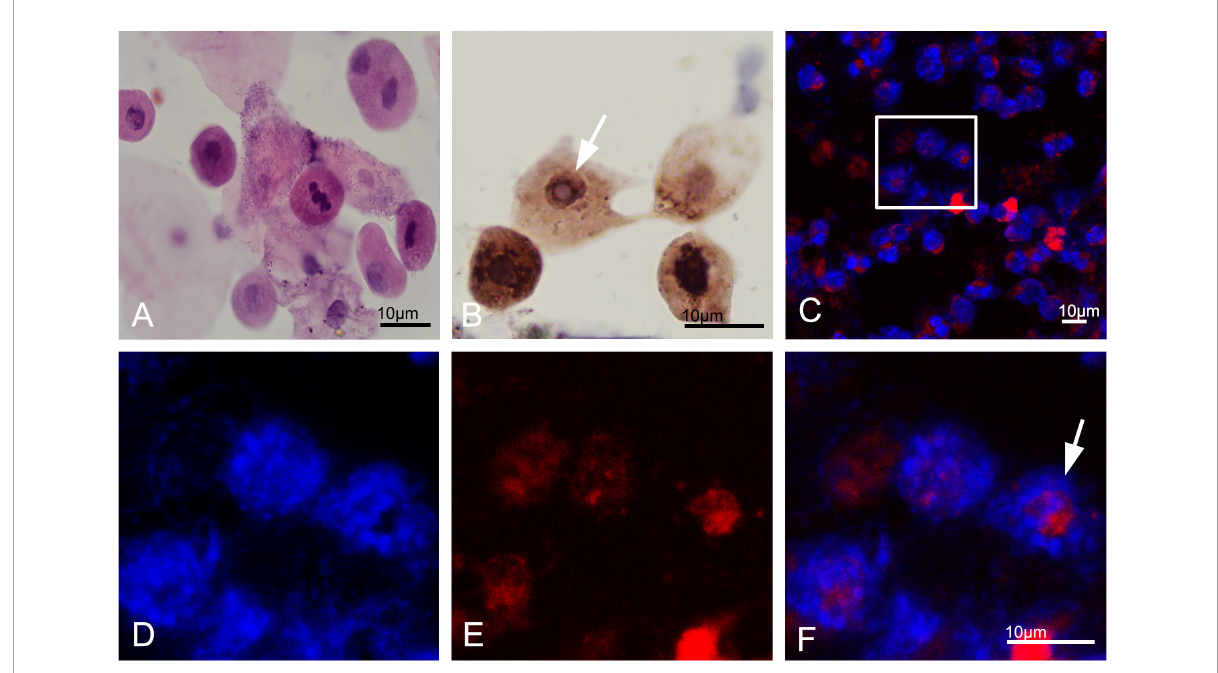
FIGURE4 Urine cytology in neuronal intranuclear inclusion disease (NIID) patients. Leukocytes, epithelial cells, and epithelial cells were observed in the urinary sediment on Giemsa staining (A) . Immunohistochemistry showed p62-positive materials in the cytoplasm of sediment cells in patient 1 (Panel B , arrow). Immunofluorescence revealed that p62-positive intranuclear inclusions were observed in patient 1 (Panels C–F were magnification,